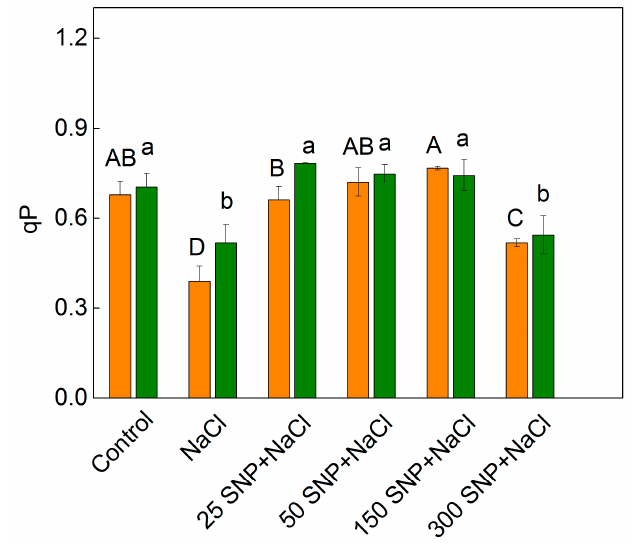
Figure 5. Effects of different SNP concentrations on the photochemical quenching (qP) under salt stress in the leaves of the two sorghum varieties (Albanus—orange bars and Shamal—green bars). Mean values ( ± SE) were calculated from eight independent measurements. The significant differences among treatments at p < 0.05 are indicated by different letters (uppercase for Albanus and lowercase for Shamal).